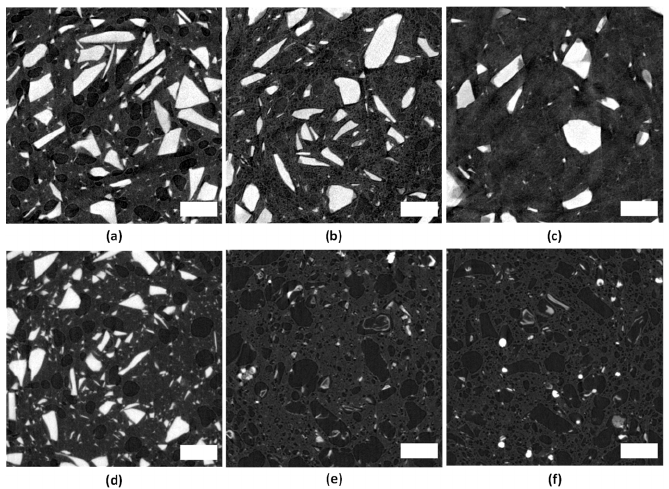
Figure 11. µ-CT images of PLA-BaG composites. Top row from left to right: Si-BaG50 ( a ) 0, ( b ) 20 and ( c ) 40 wk and bottom row from left to right: P-BaG35 ( d ) 0, ( e ) 20 and ( f ) 40 wk. Scale bar 200 µm.